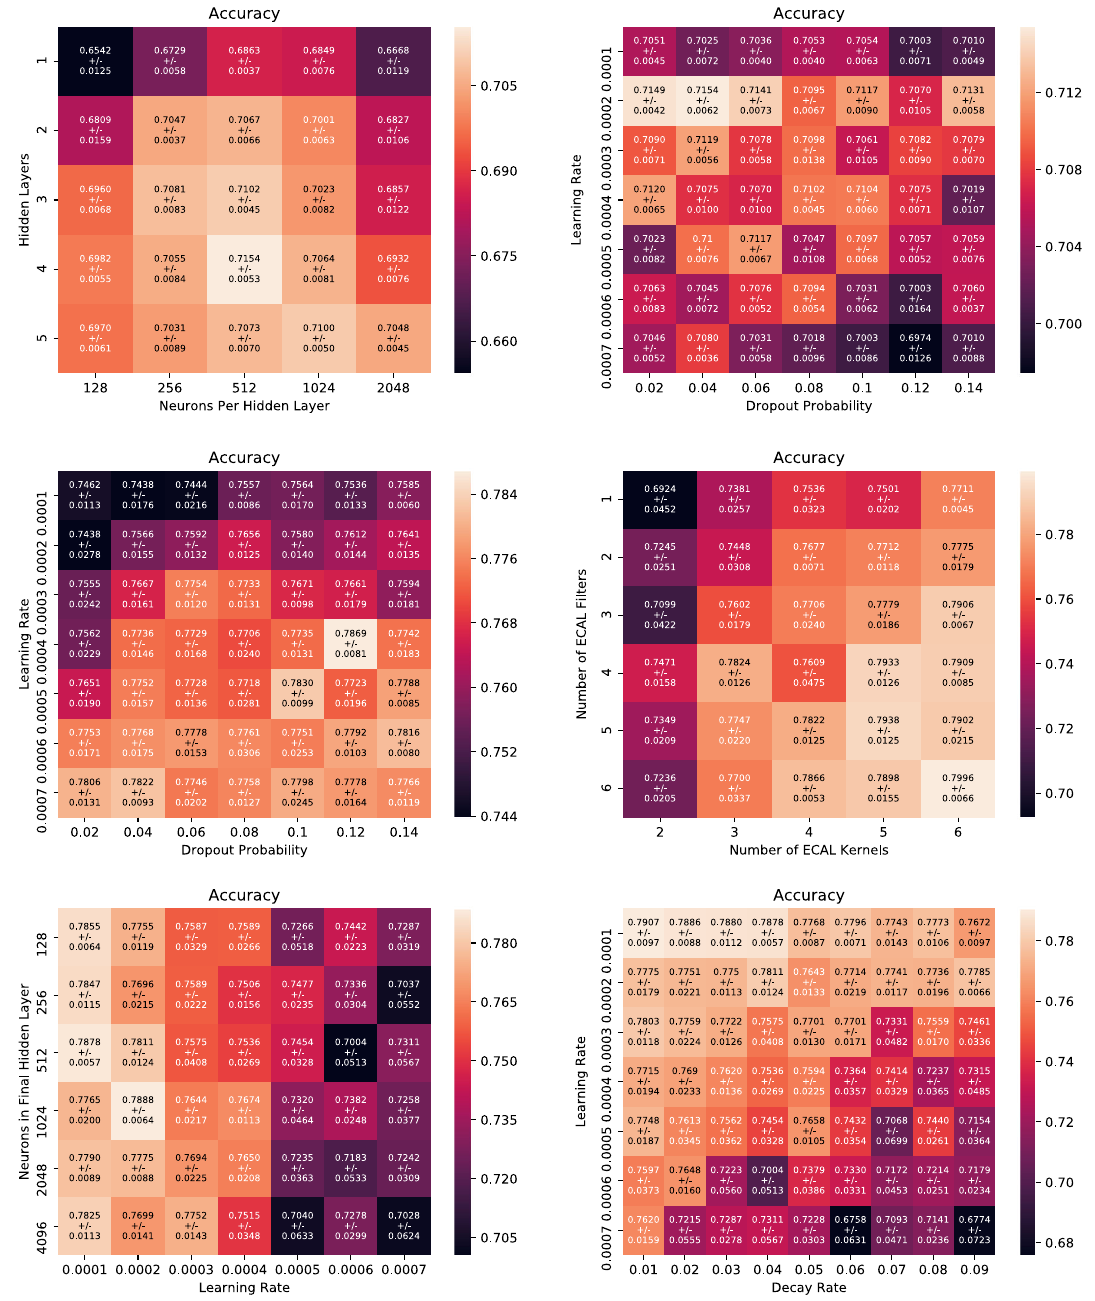
Fig. 11 Selected hyperparameter scan results for DNN (top), CNN (center), and the GoogLeNet-based architecture (bottom). In each figure, the classification accuracy is displayed as a function of the hyperparameters reported on the two axes